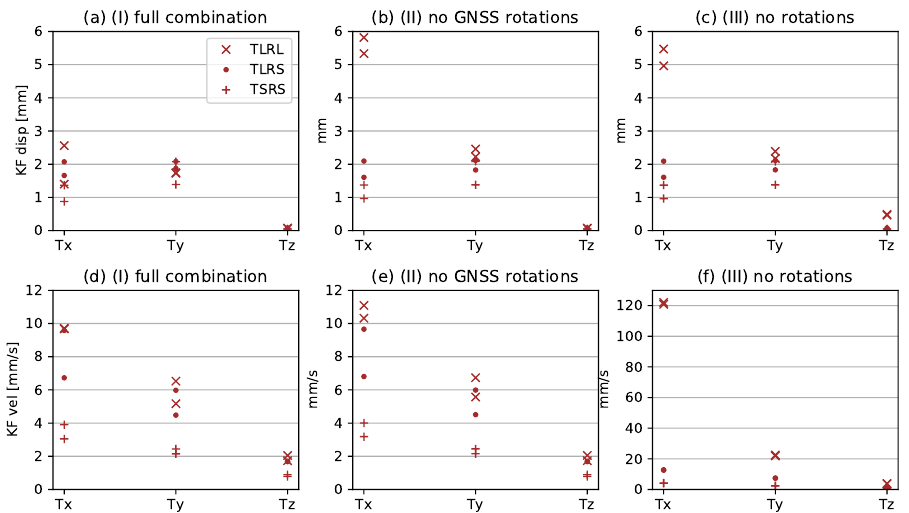
Figure 8. Summary of KF performance in terms of RMSE. ( a – f ) show the KF estimates of displacement and velocity. The ( a ) and ( d ) show the RMSE when applying the ( I ) full combination method. ( b ) and ( e ) ignore the rotation of GNSS ( II ). ( c ) and ( f ) assume that no rotational information is available ( III ). The subplots have different scales on the x -axis for better